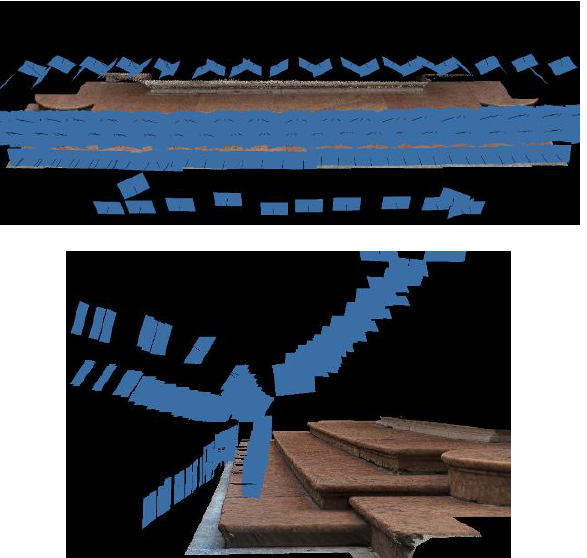
Figure 7. Example of the image acquisition scheme: perspective views of the South side mesh of the steps with the photos location (blue rectangles).